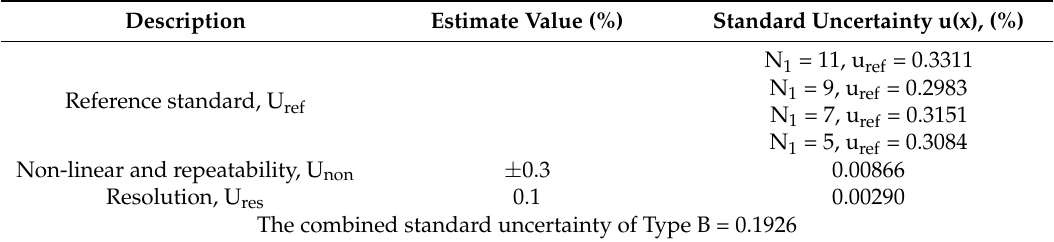
Table 10. The Type B uncertainty analysis for resistive humidity sensor.